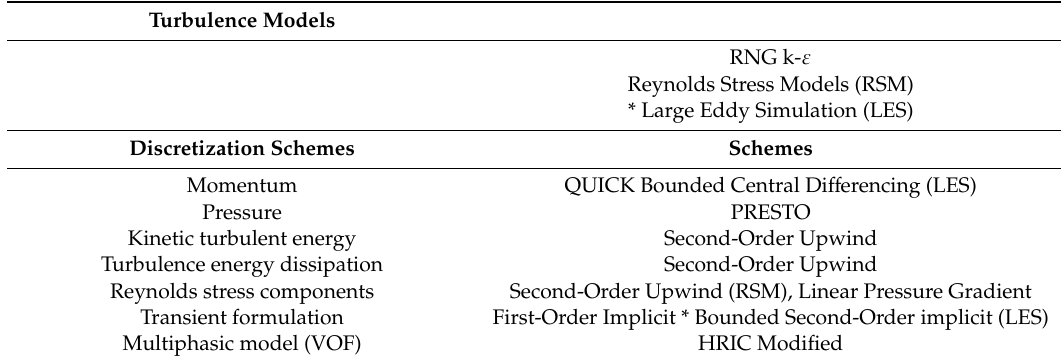
Table 3. Set up case, turbulence models, and discretization scheme. RNG: renormalization group, VOF: volume of fluid. * represents the set up used for the LES